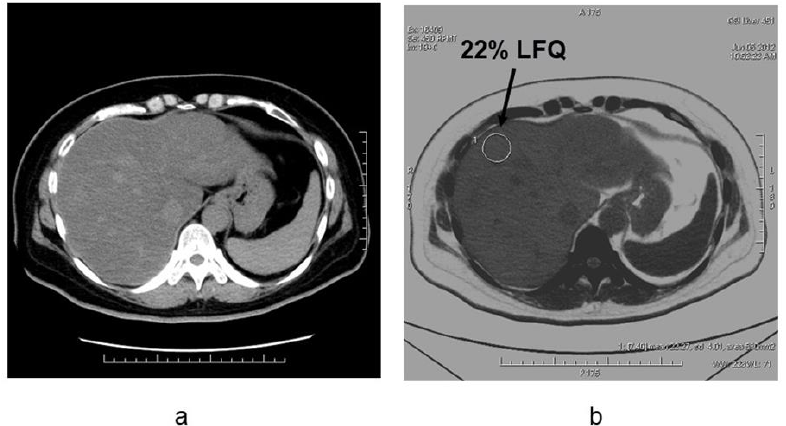
Figure 6. Liver fat measurements by using dual-energy CT in the patient with NAFLD (non-alcoholic fatty liver disease) ( a ) Noncontrast CT image and ( b ) fat density image in patients with nonalcoholic fatty liver disease. The degree of fat deposition was quantifiable on the fat density images, and the quantitative assessment of liver tissue and fat in this case was 22% liver-fat quantification.